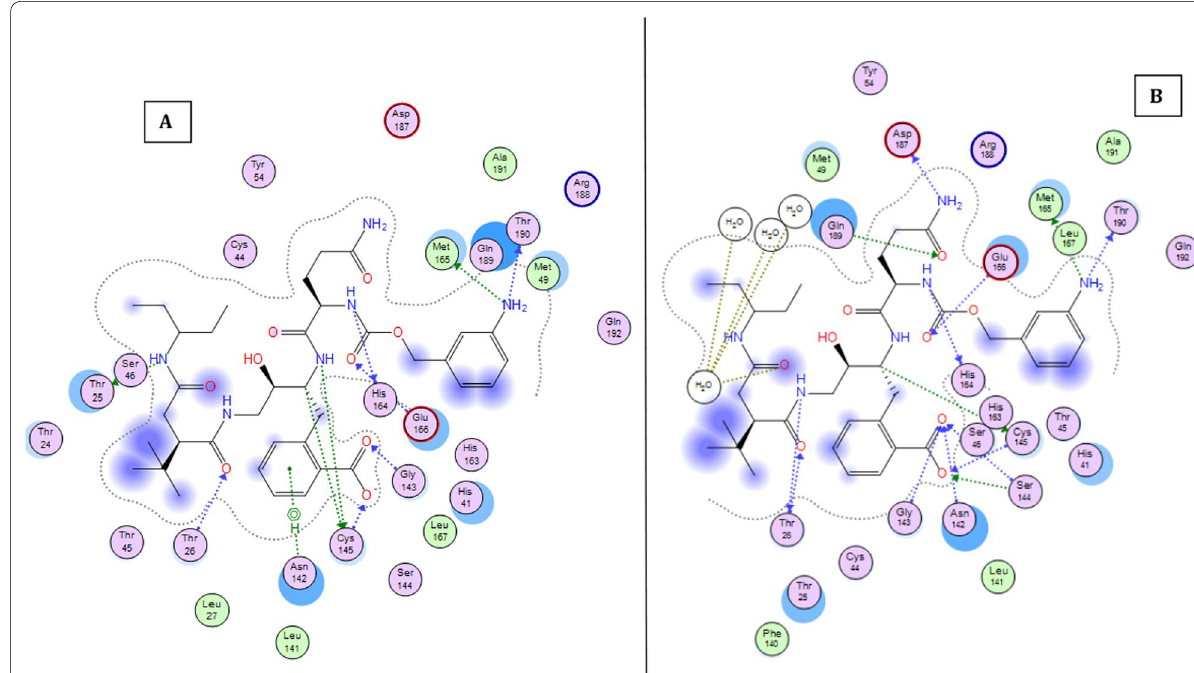
Fig. 15: 2d interaction of inhibitor with Index number 847b A Before Molecular dynamics study and B After Molecular dynamics analysis